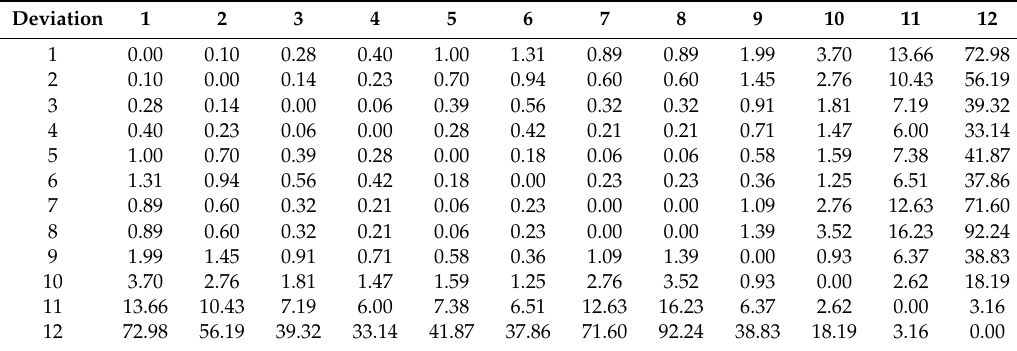
Table 6. Deviation between two units in Table 5.